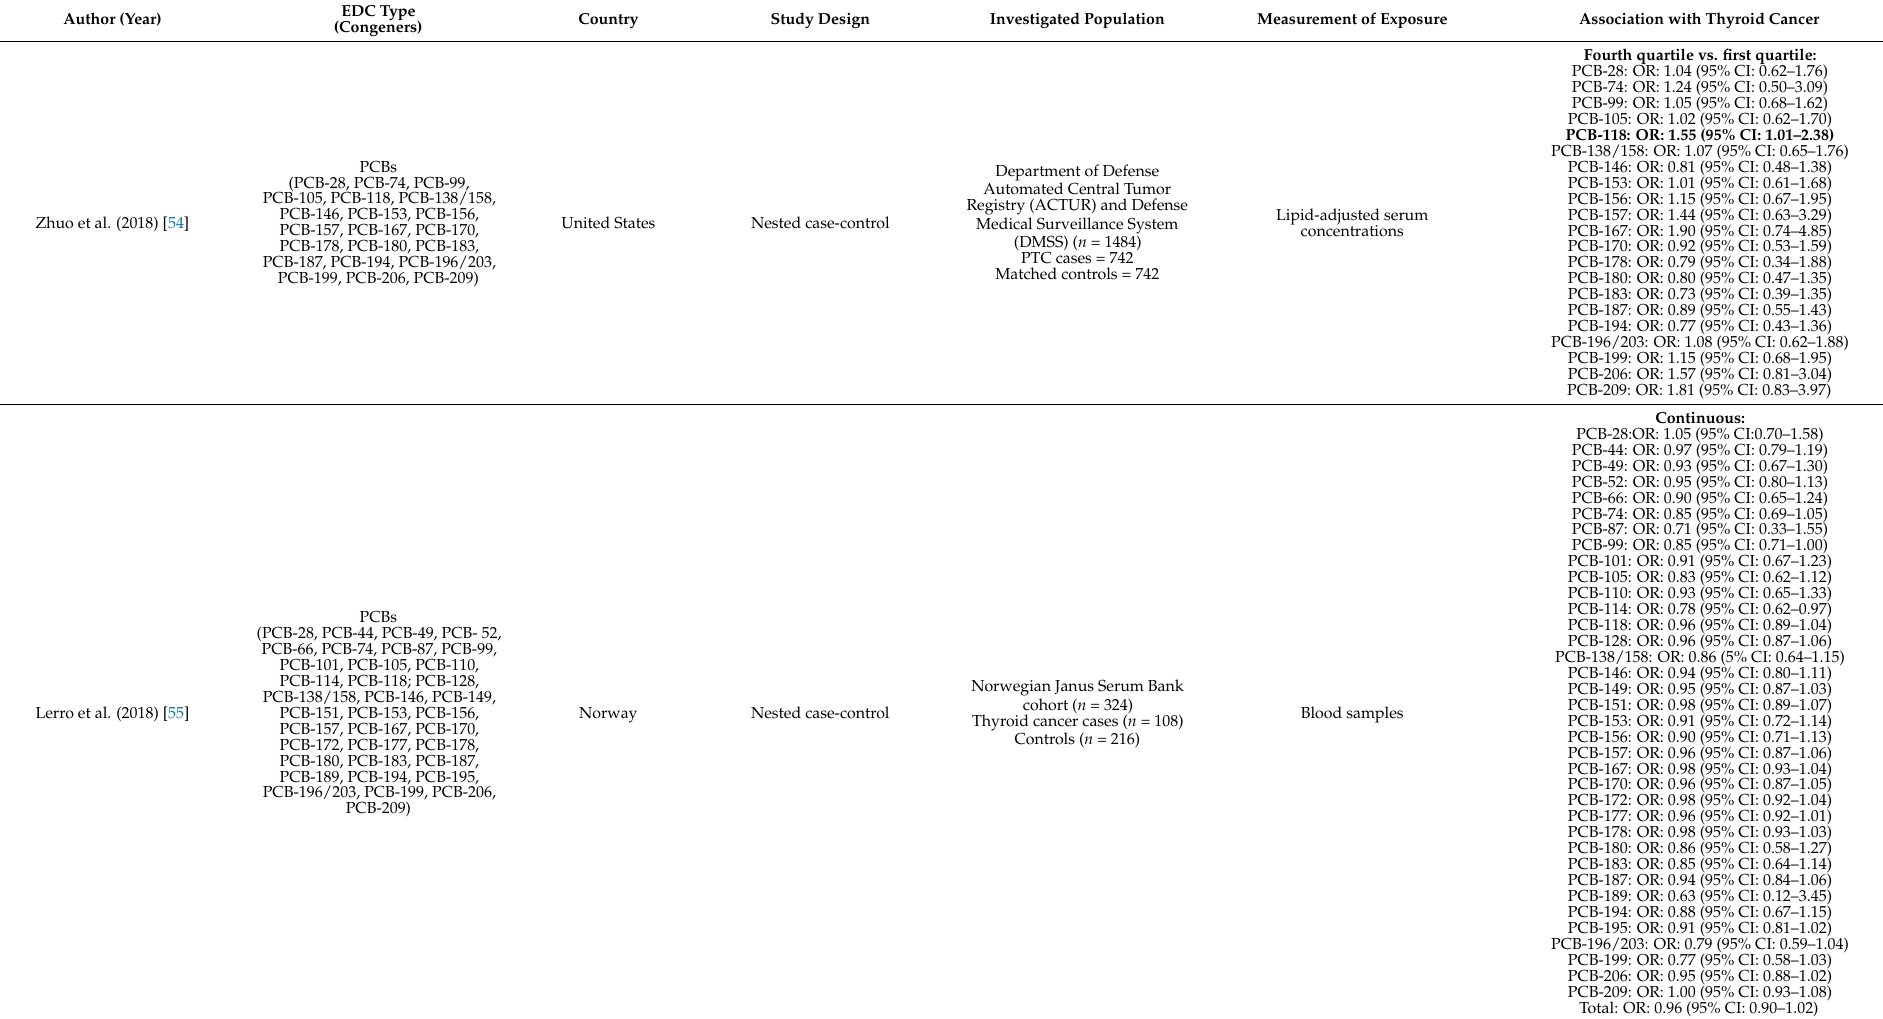
Table 2. Association between exposure to PCBs and thyroid cancer. Abbreviations: CI: confidence interval; EDC: endocrine disrupting chemicals; OR: odds ratio; PCB: polychlorinated biphenyls; SMR: standardized mortality